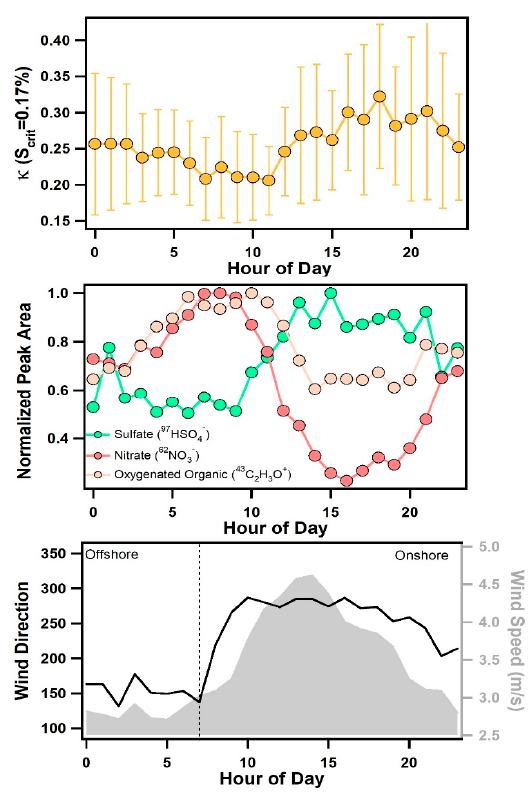
Figure 6. Diurnal profile of κ at 0.17% supersaturation with error bars representing the standard deviation ( top panel ), sulfate, nitrate, and oxygenated organic aerosol ion peaks measured by ATOFMS ( middle panel ), and wind speed and direction ( bottom panel ).